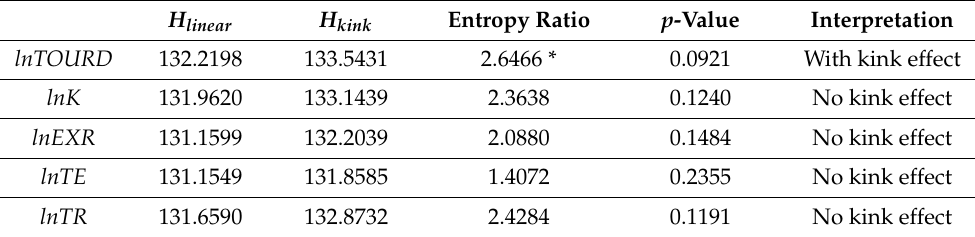
Table 4. Entropy ratio test. H linear H kink Entropy Ratio p -Value